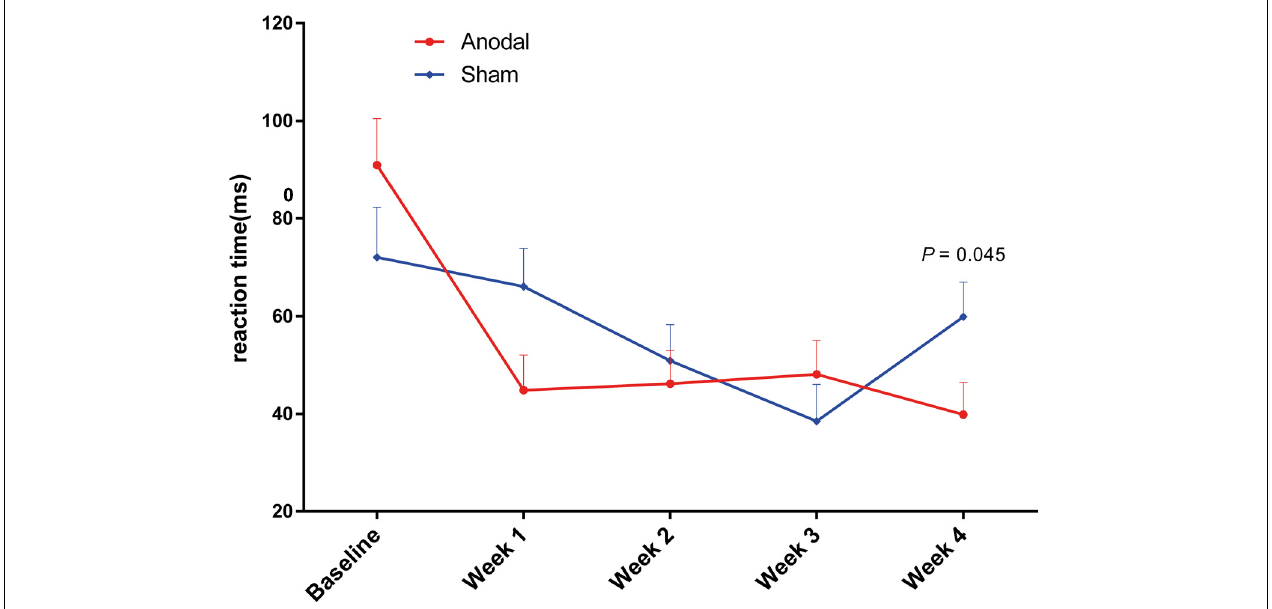
FIGURE 5 | Variation in reaction time on executive under ANT from baseline to week 4 in the anodal group and the sham group. Error bars represent SEM for the change in reaction time. P -value is calculated by the comparison between two groups.